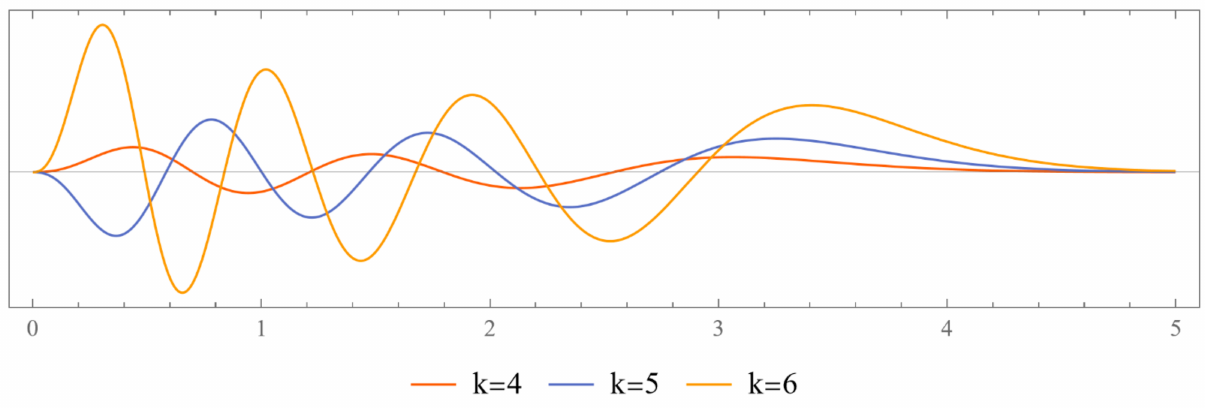
Figure A21. The un-normalized wavefunction (cid:101) ψ ( r , E k ) for different values of k . The horizontal r -axis is in units of λ − 1 . We took µ = − 15, γ = 16, and ν = 1. We can observe each wavefunction having k nodes, and vanishes at the boundaries.